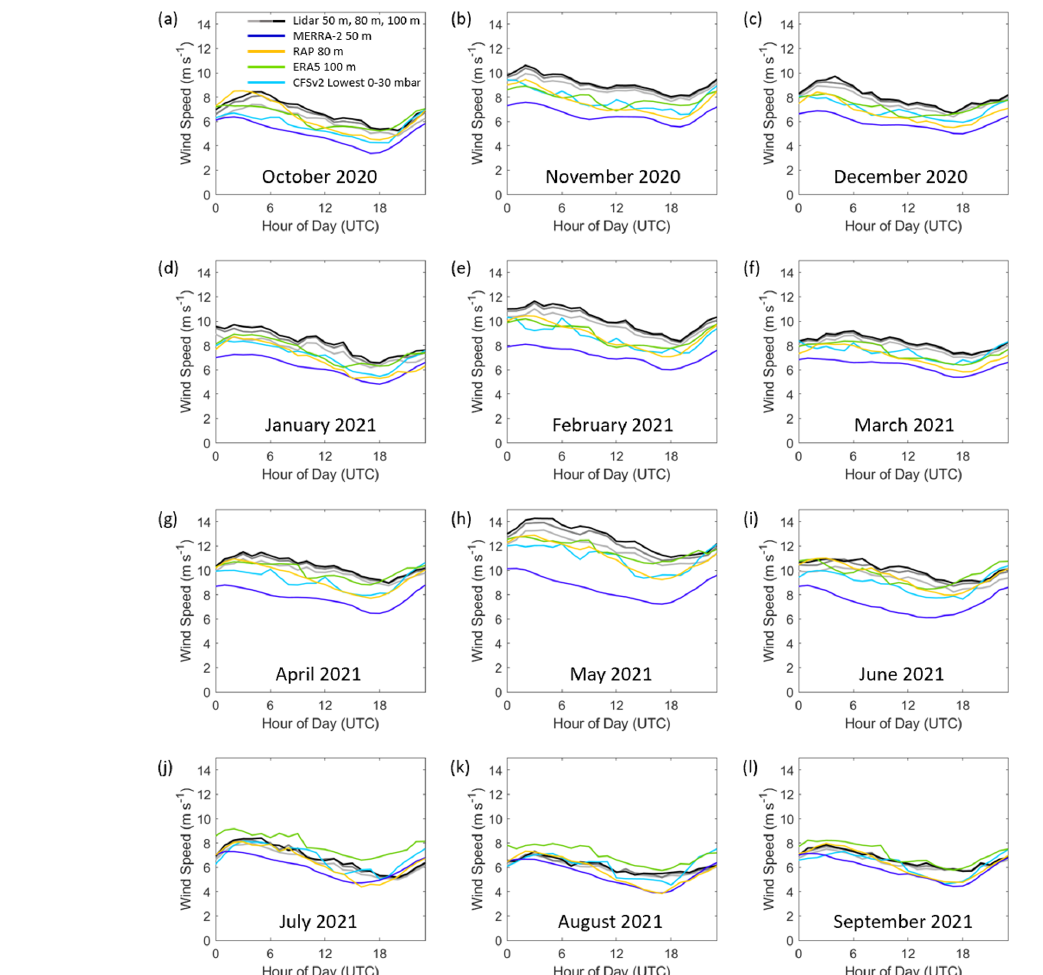
Figure 13. Observed and modeled diurnal trends in wind speed at Morro Bay according to month.